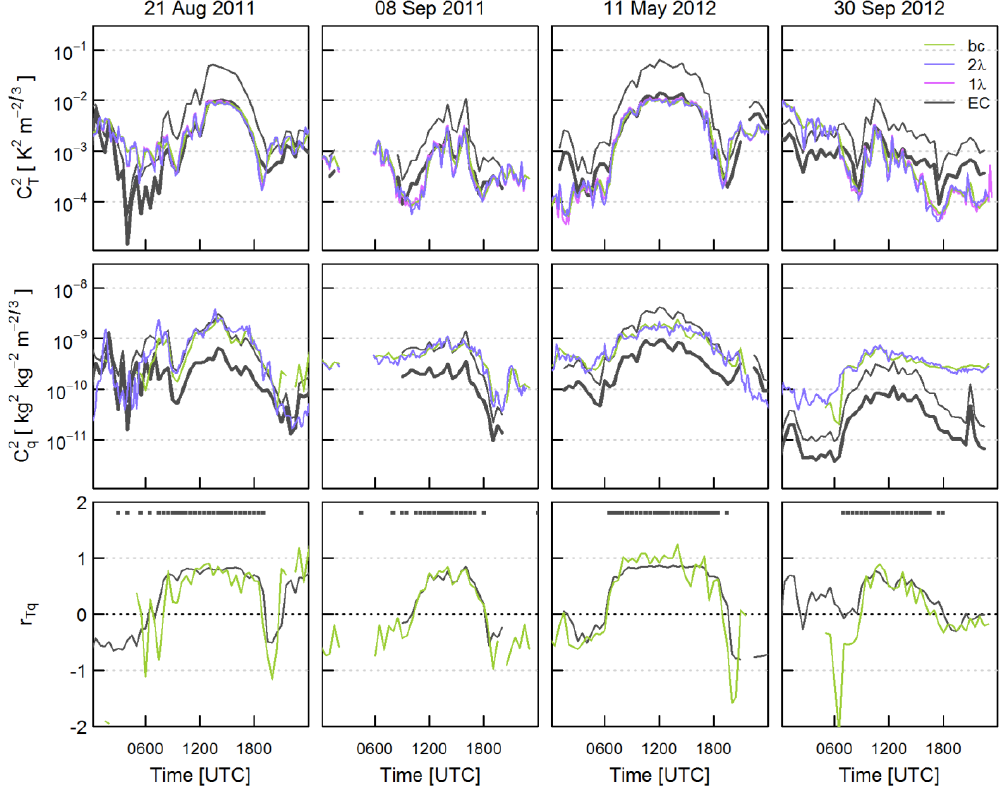
Figure 8. Structure parameters of temperature and humidity and the temperature–humidity correlation coefficient for selected days, derived from eddy covariance measurements (EC) and from the BLS–MWS system using the single-wavelength (1 λ ), two-wavelength (2 λ ) and bichromatic-correlation (bc) methods. EC structure parameters are shown for the EC measurement height (thin line) and scaled to the effective height of the scintillometry results (thick line). Unstable times according to the EC data ( L Ob < 0) are indicated by grey dots. Single-wavelength and two-wavelength data are for 10min intervals; EC and bichromatic-correlation data are for 30min